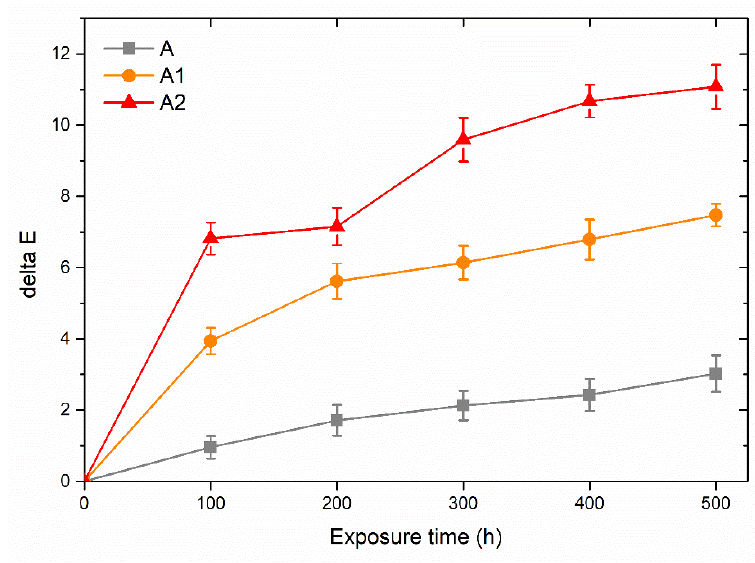
Figure 12. Total color variation during UV-B exposure.